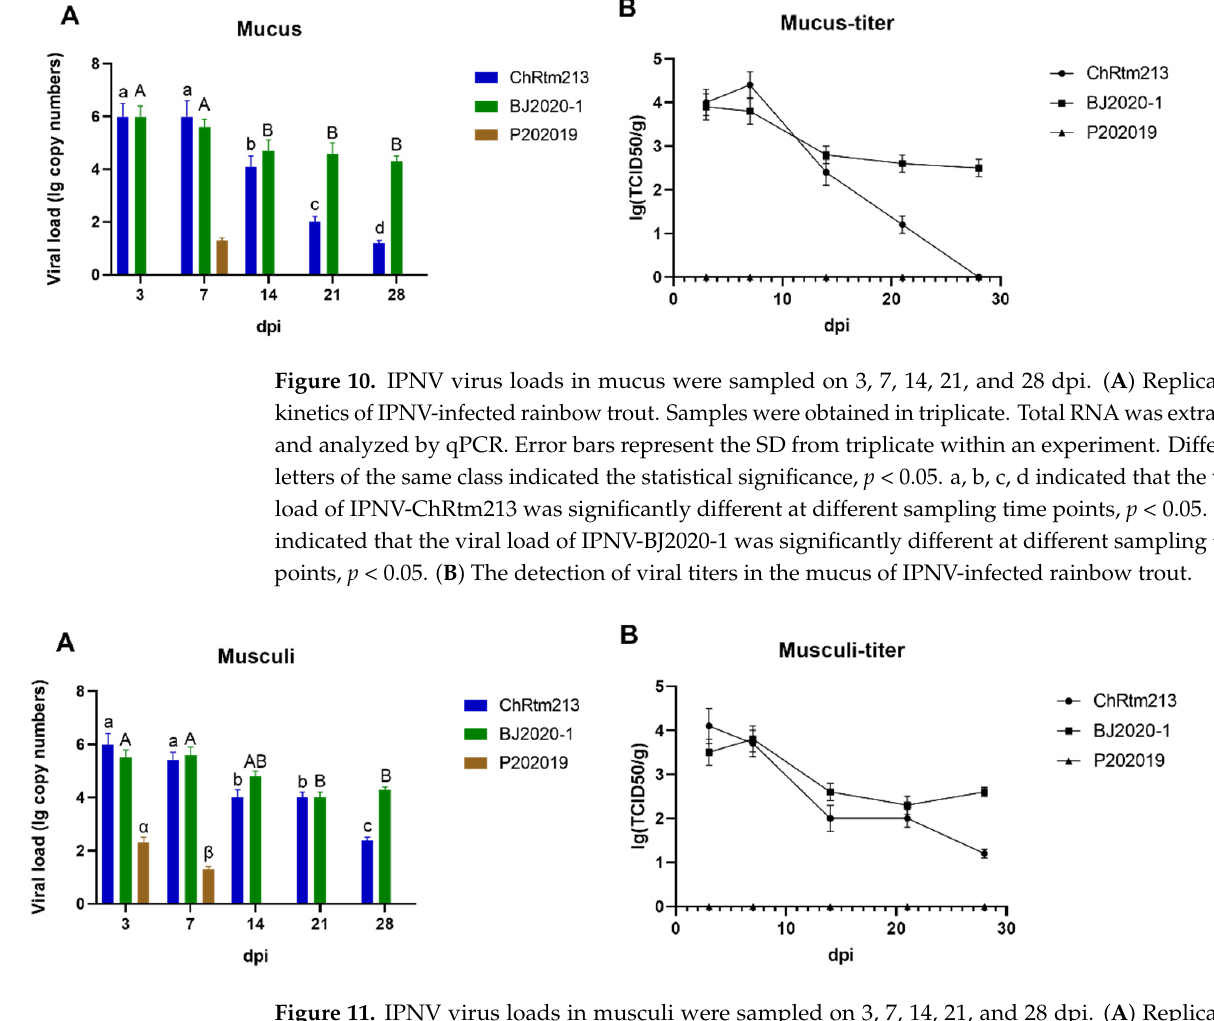
Figure 11. IPNV virus loads in musculi were sampled on 3, 7, 14, 21, and 28 dpi. ( A ) Replication kinetics of IPNV-infected rainbow trout. Samples were obtained in triplicate. Total RNA was extracted